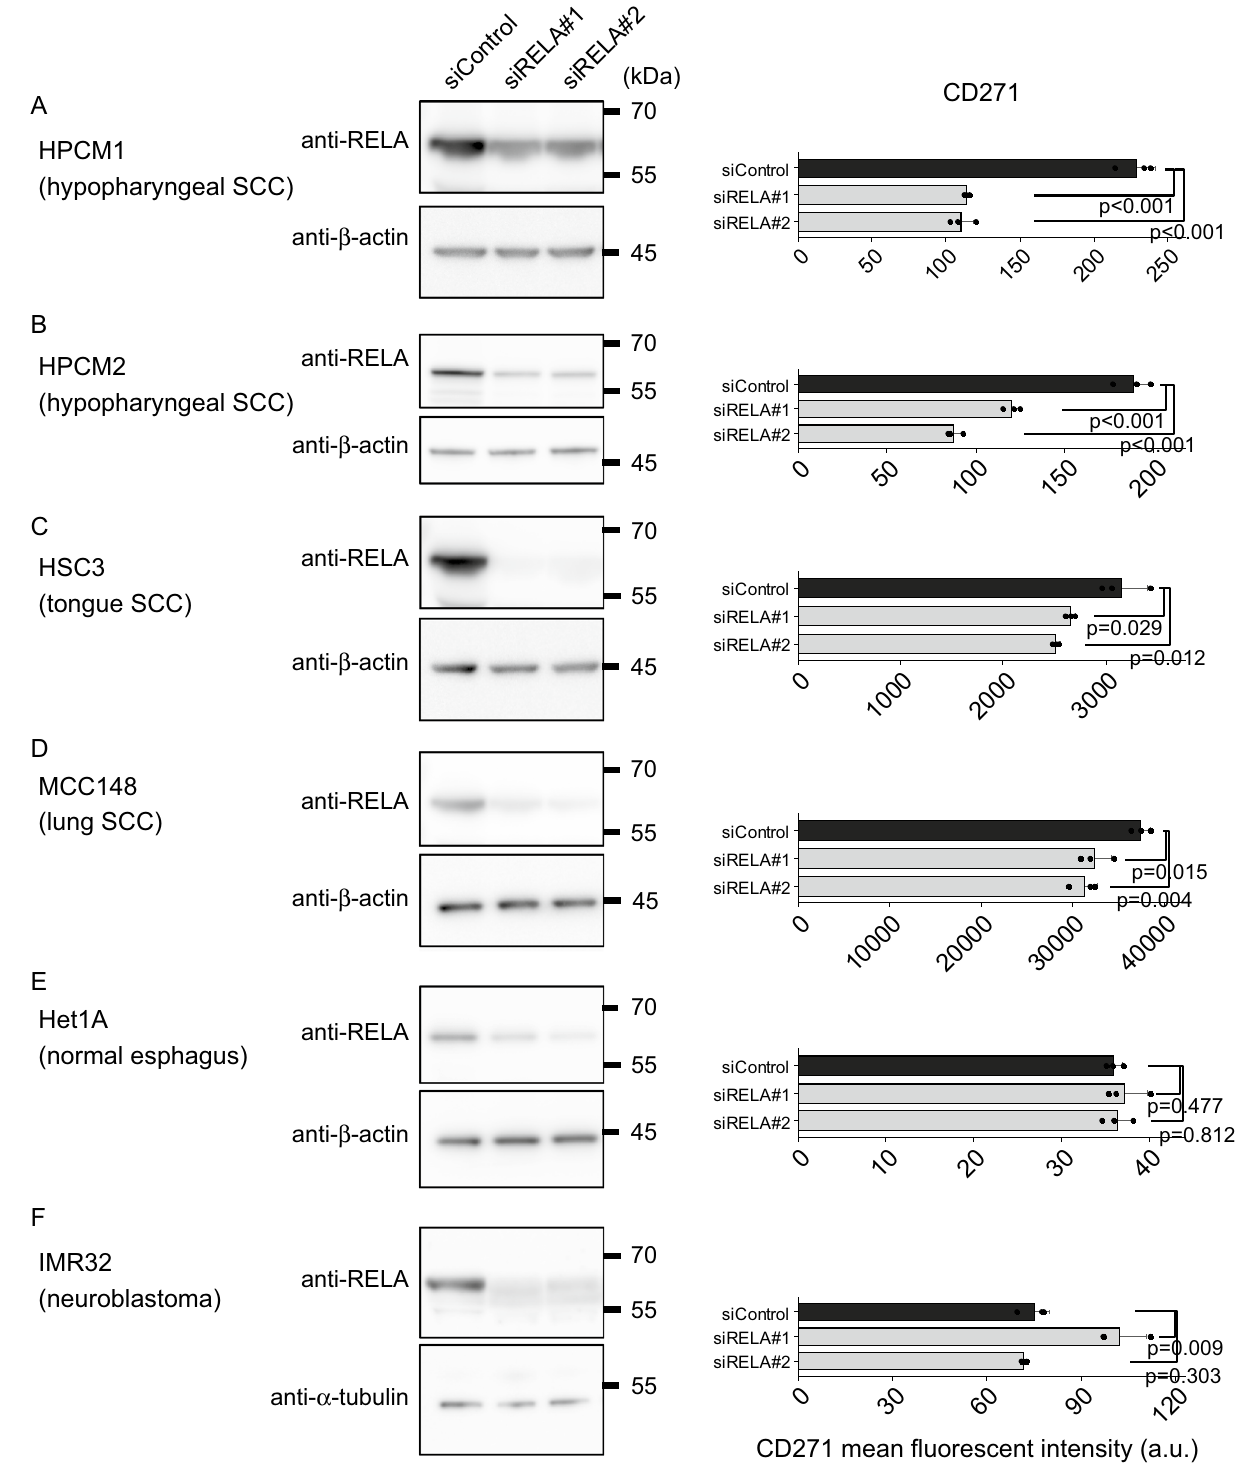
Figure 2. RELA is required for CD271 expression in squamous cell carcinoma cell lines. ( A )–( F ) Cells were transfected with siRNA targeting RELA , followed by western blot of RELA and flow cytometric analyses of CD271 expression. SCC, squamous cell